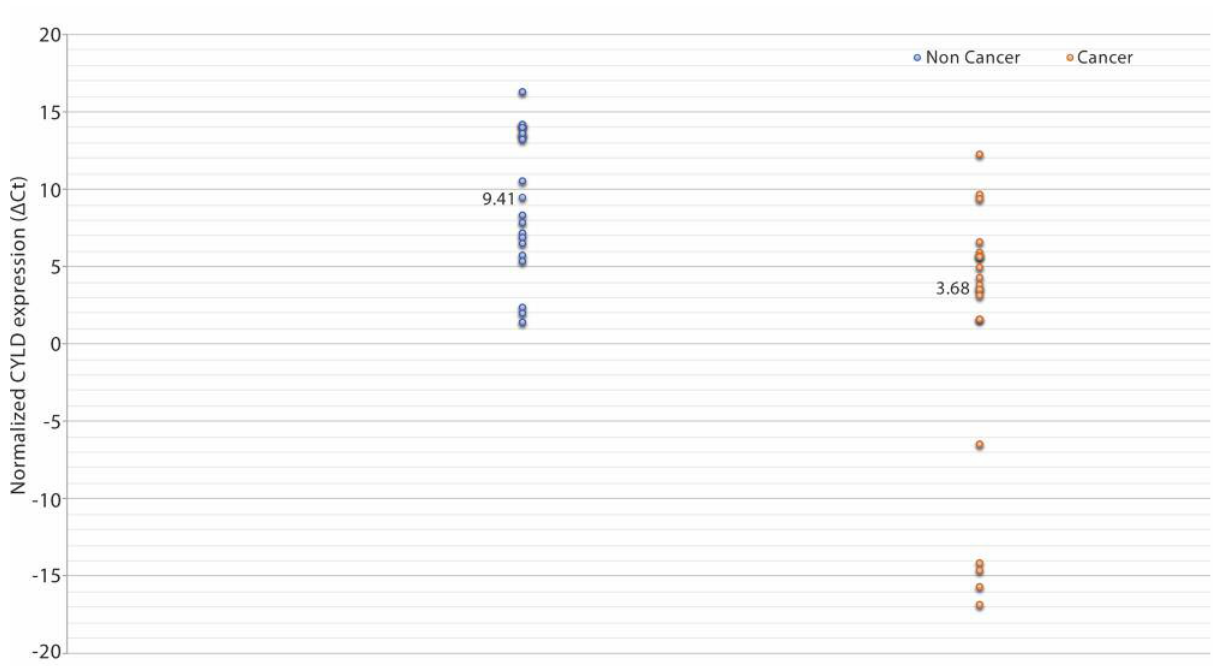
Figure 2. Detection of CYLD mRNA in FFPE sections of patients with ccRCC. Total RNA was extracted from cancerous (cancer) and adjacent normal tissue (non cancer) of FFPE sections of ccRCC and used to determine the relative levels of CYLD mRNA by RT-PCR. The scatter plot indicates normalized Ct values ( ∆ Ct) of relative CYLD mRNA levels with YWHAZ being used as endogenous control. Statistical analysis of relative CYLD mRNA expression comparison between the cancerous and the matched normal tissue was per- formed by the paired Student’s t-test method ( p < 0.001). The median score was also calculated for cancerous tissue (3.68) as well as for the adjacent normal tissue (9.41) indicating the expression di ff erence between the two tissue